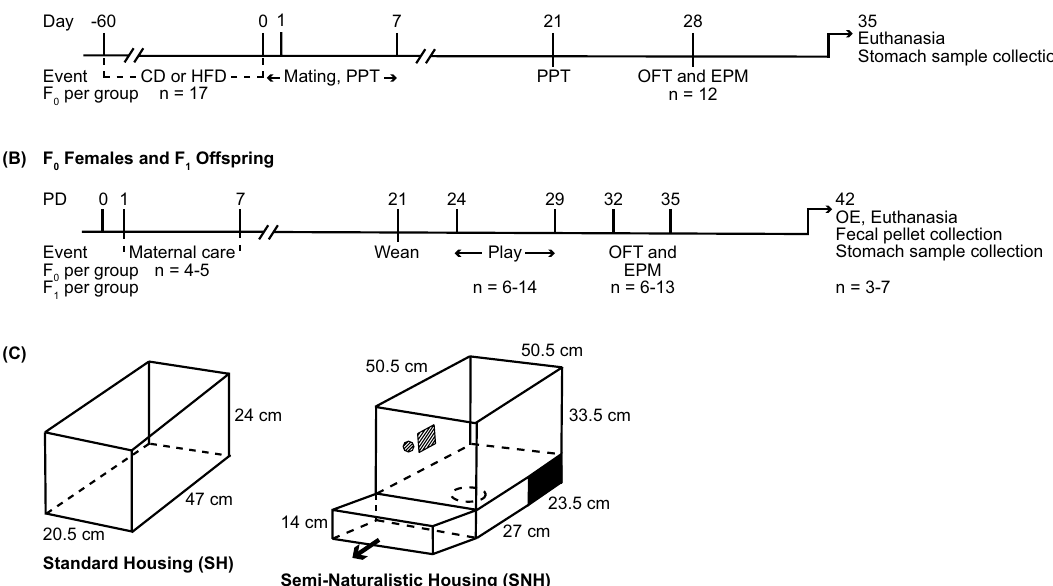
Acute stress exposure in peri‑adolescent offspring and fecal microbiome sample collec‑ tion. We used the Predator Odor Exposure Test to identify ethologically relevant differences in responses to acute stress exposure 43,70 . Testing of responses to acute stress exposure in F 1 offspring in the odor exposure (OE) arena (clear Plexiglas walls and lid with ventilation holes and white Plexiglas floor; 60 cm × 27 cm × 35.5 cm) was conducted on PD42. F each F 1 offspring rat were removed directly from the OE arena and immediately frozen at − 80 °C until further processing. At harvest, whole stomachs were dissected and flash-frozen on dry-ice and shipped to the University of Colorado Boulder. Between each trial, the OE arena was cleaned with 30% ethanol solution. Stomach microbiome sample collection. Stomach microbiome sample collection was conducted in a sterile BSL2 cabinet using sterile technique. Stomachs, individually wrapped in aluminum foil, were removed from the − 80 °C freezer, thawed on wet ice, and then dissected along the lesser curvature with a sterile scalpel